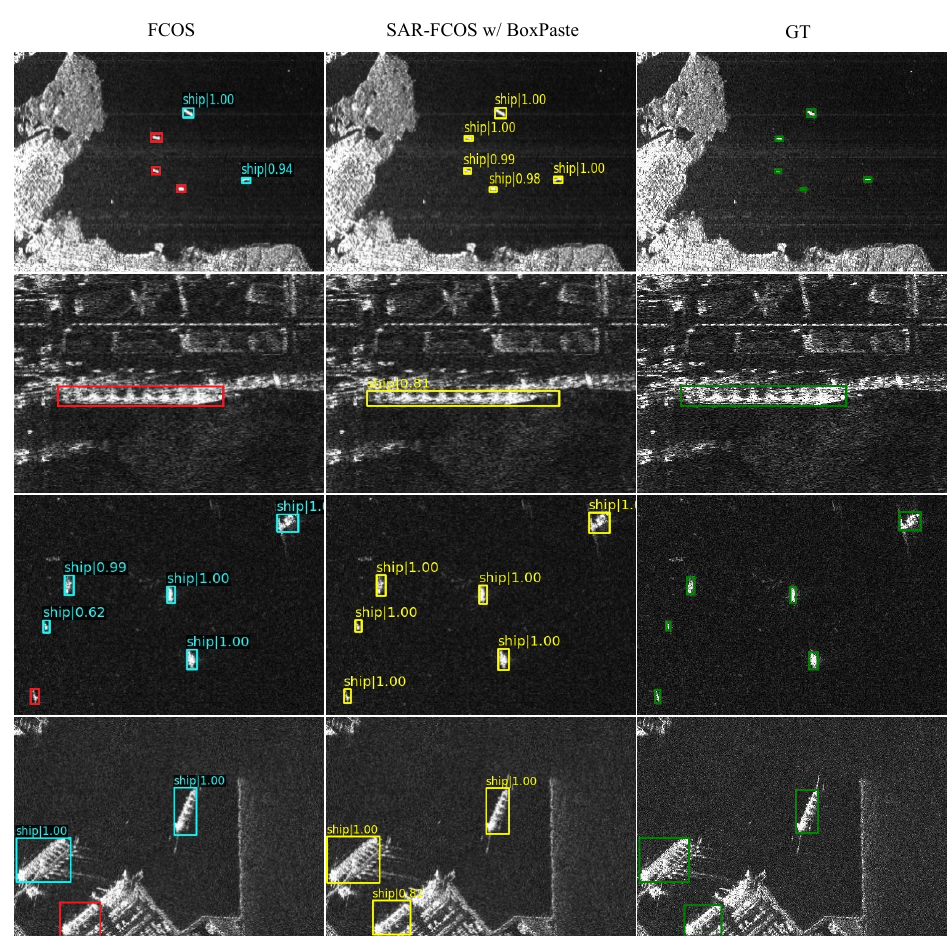
Figure 6. Visualization of the detection results of FCOS, SAR-FCOS with BoxPaste, and ground-truth. The cyan, red, yellow, and green boxes indicate the test results of FCOS, the ship object missed the test results of ours, and the ground truth. Table 2. Ablation study on BoxPaste with regard to scale jittering and training epochs. Scale Jit.